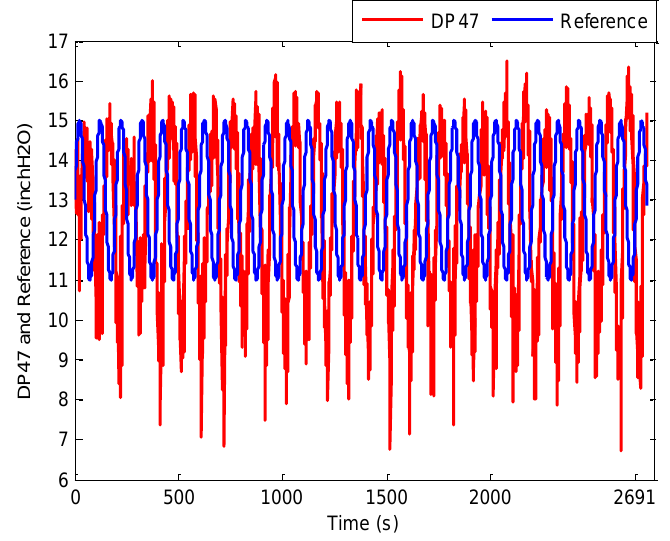
Figure 11. Pressure difference response of riser during sinusoidal setpoint changes.